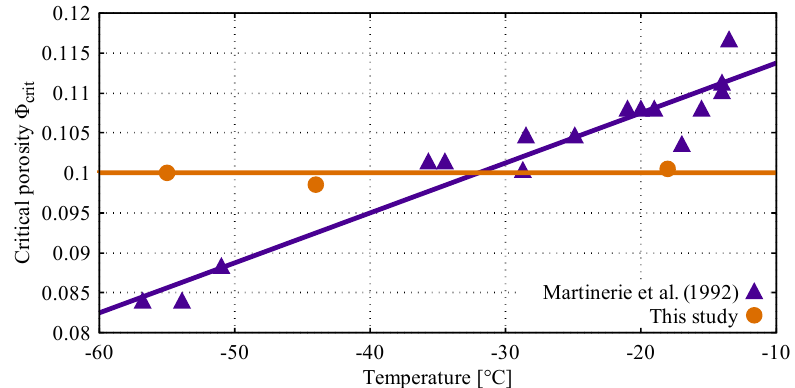
Figure 3. Critical porosity versus temperature. The given linear relation is commonly fit to the data of Martinerie et al. (1992), a study based on air-content measurements of 495 deep ice samples from 16 cores (with a minimum of only two measurements for one core). From their results, they reconstruct the average ice density at air isolation, which is equivalent to the porosities shown here. In contrast, we analyzed the microstructure of 1163 firn samples for three cores (see Table 1), allowing the direct determination of the critical porosity of gas enclosure within a single layer.